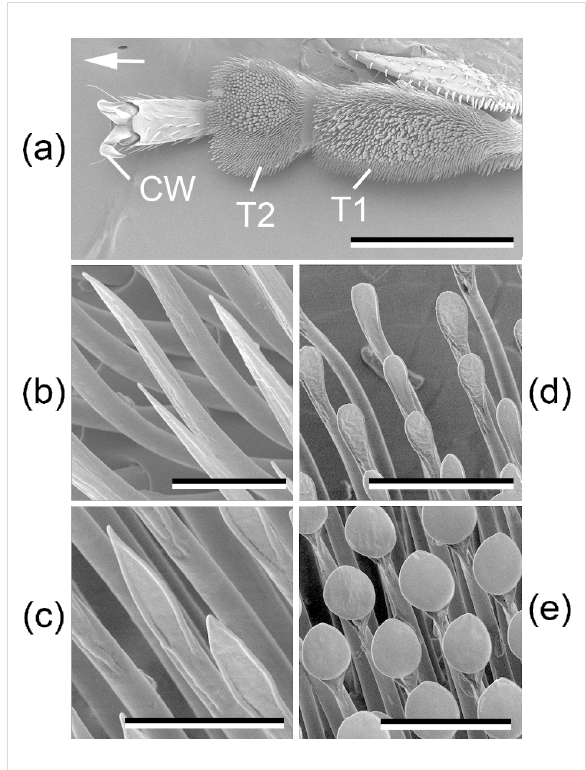
Figure 5: SEM micrographs of tarsal attachment devices in the male beetle Coccinella septempunctata : tarsus of the foreleg (a) and different types of tenent setae (b–e). Arrow in (a) shows the distal direction. CW, claw; T1, first proximal tarsomere; T2, second proximal tarsomere. Scale bars = 500 μ m (a), 20 μ m (d,e), 10 μ m (b,c). Adapted from